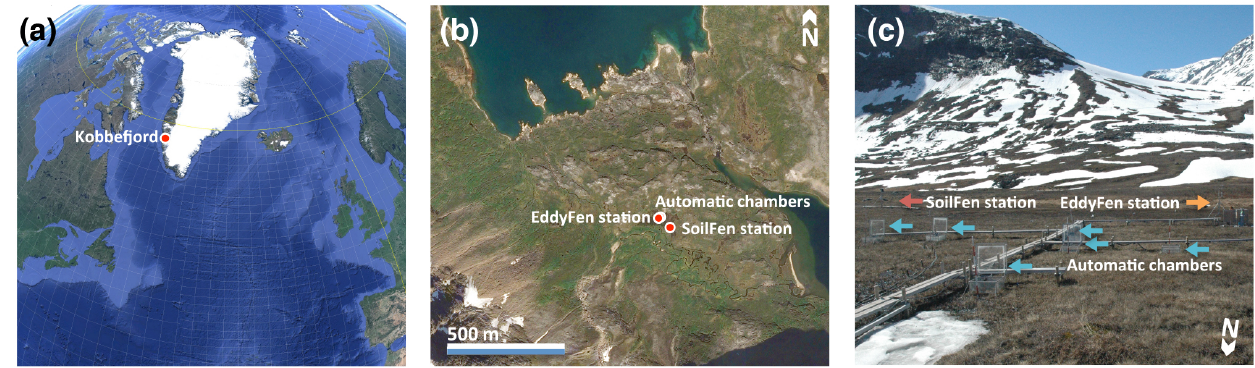
Figure 1. (a) Location of Kobbefjord in Greenland, 64 ◦ 07 (cid:48) N; 51 ◦ 21 (cid:48) W (source: Google Earth Pro). (b) Location of EddyFen station, automatic chambers and SoilFen station in Kobbefjord (source: Google Earth Pro, 16 July 2013). (c) Eddy covariance (orange arrow) from EddyFen station, six automatic chambers (light blue arrows) and SoilFen station (pale red arrow) (photo by Efrén López Blanco, 27 June